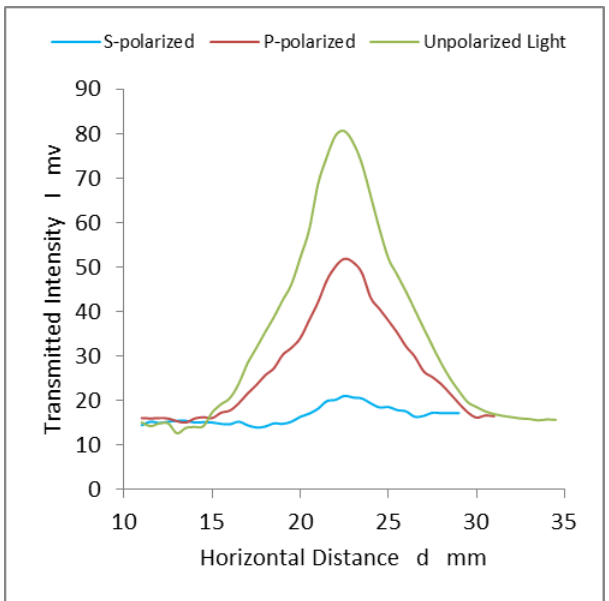
Fig. 4: Transmission intensity variation along the horizontal distance for unpolarized, S- polarized, and P – polarized light,